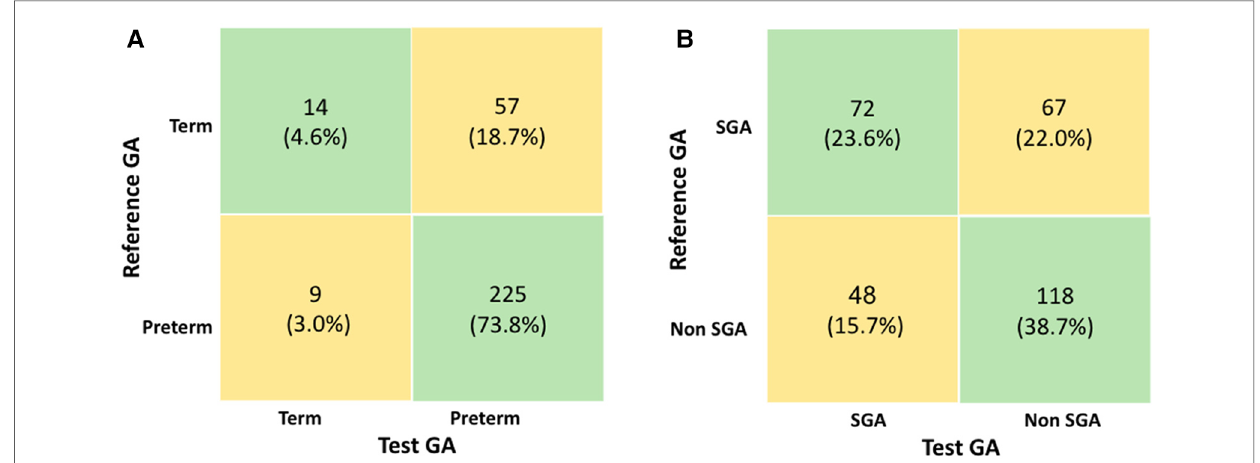
FIGURE 6 ( A ) Confusion matrix for classi fi cation of preterm and ( B ) confusion matrix for classi fi cation of small for gestational age newborns. GA, gestational age; LMP, last menstrual period; SGA, small for gestational